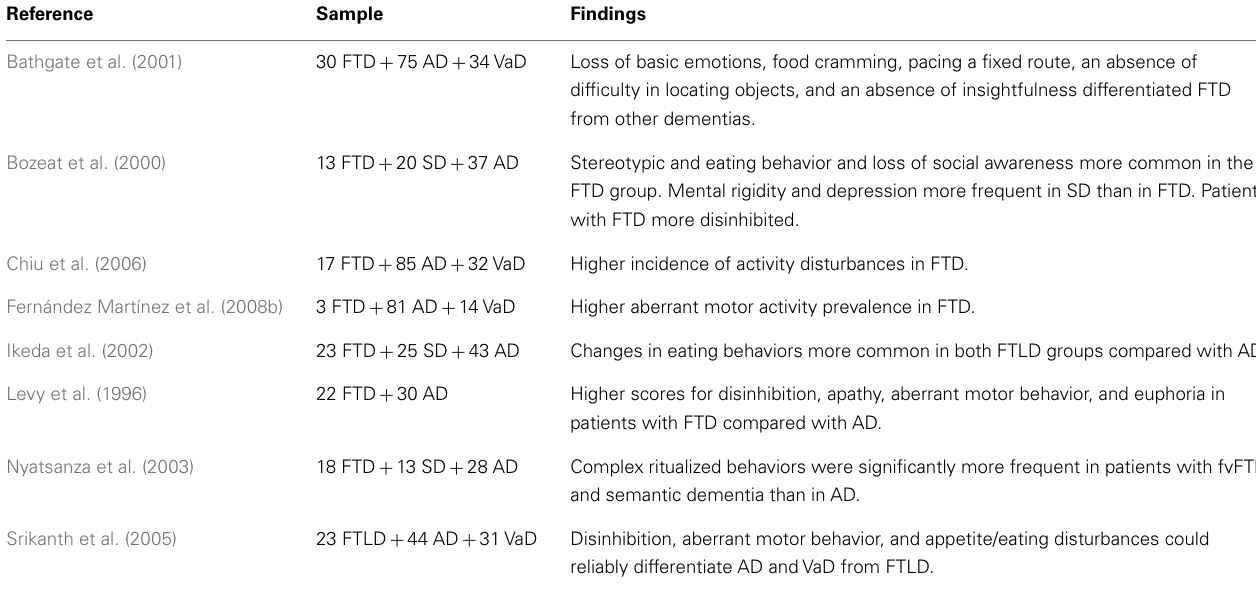
Table 5 | BPSD:Alzheimer’s disease vs. fronto-temporal lobar